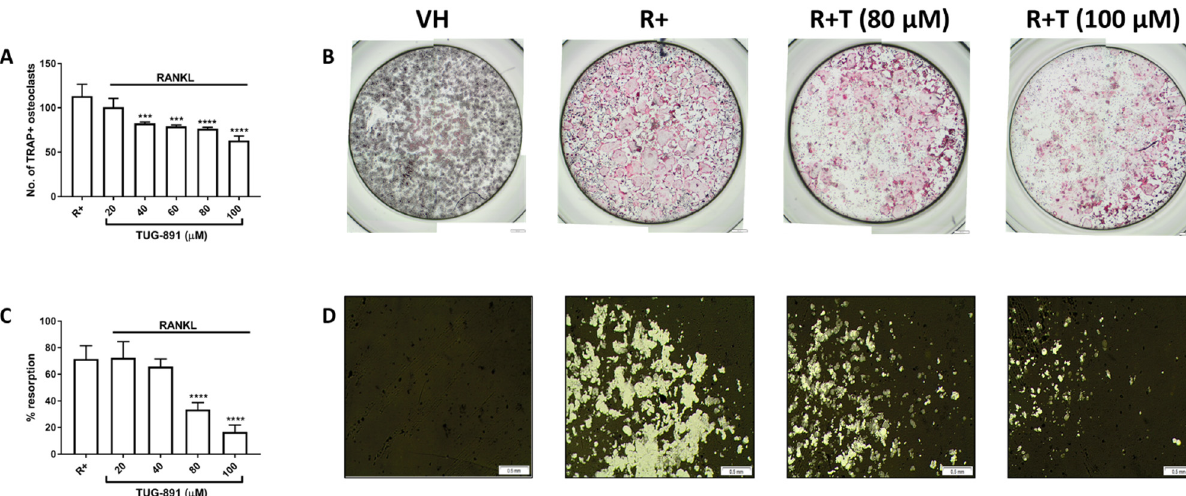
Figure 2. Effect of TUG-891 on osteoclast formation and resorption. ( A ) RAW264.7 macrophages were seeded into 96-well plates and exposed to TUG-891 (20–100 µ M) and RANKL (15 ng mL − 1 ) together, for 5 days. Medium and all factors were replaced on day 3. Tartrate-resistant acid phosphatase (TRAP) positive cells with 3 or more nuclei were counted. ( B ) TRAP- stained cells were visualized under a light microscope. Cells that stain positive for TRAP appear pink. Scale bar = 500 µ m. ( C ) RAW264.7 macrophages were seeded into an osteo assay surface multiwell plate and exposed to TUG-891 (20–100 µ M) and RANKL (30 ng mL − 1 ) for 5 days. Medium and all factors were replaced on day 3. The resorbed areas were quantified using ImageJ software. ( D ) The plates were stained using a modified von Kossa stain. Resorption pits appear white. Scale bar = 0.5 mm. VH: vehicle control. R+: RANKL only. R+T: RANKL + TUG-891. *** p < 0.001, **** p < 0.0001 vs. R+.